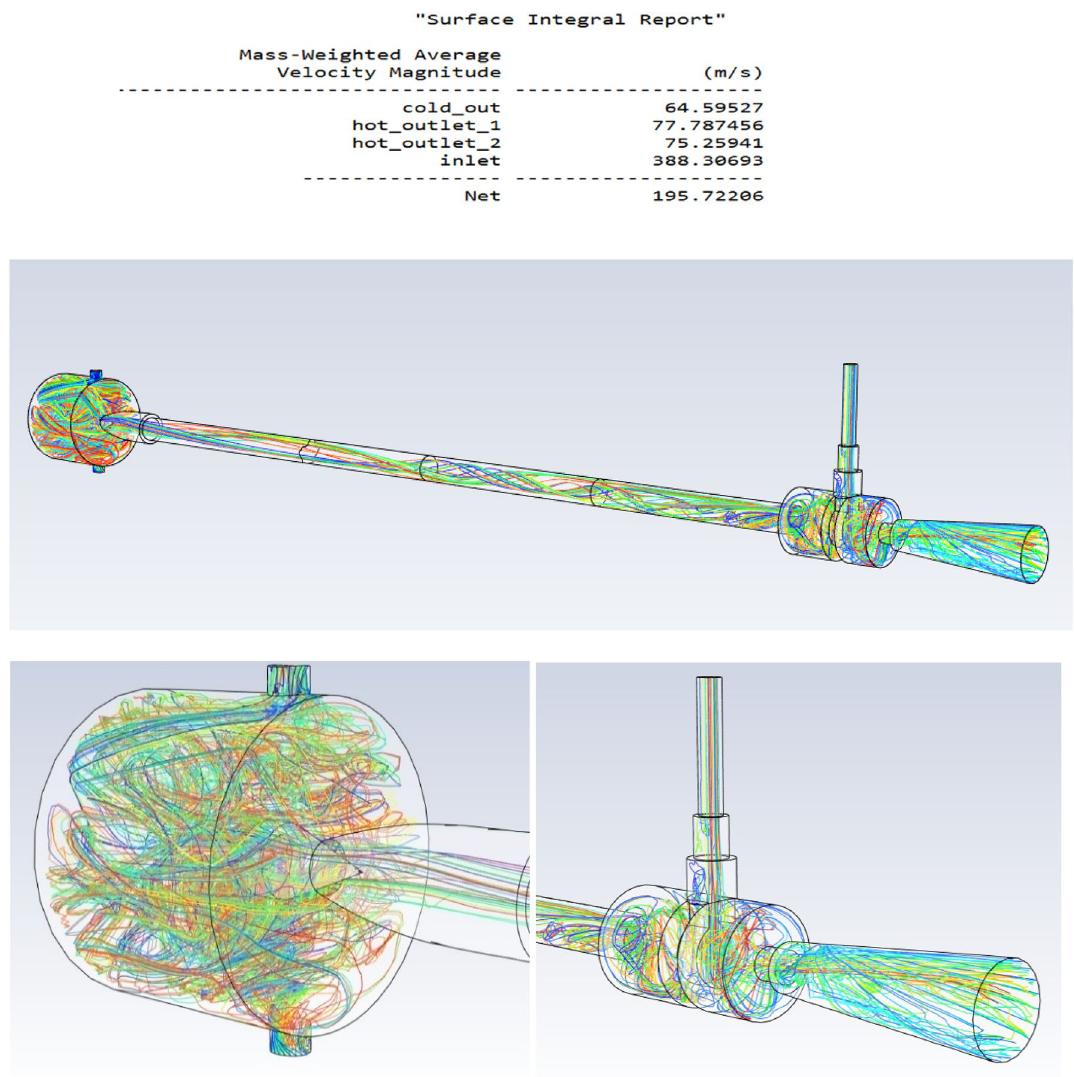
Figure 64. Streamlines of the vortex